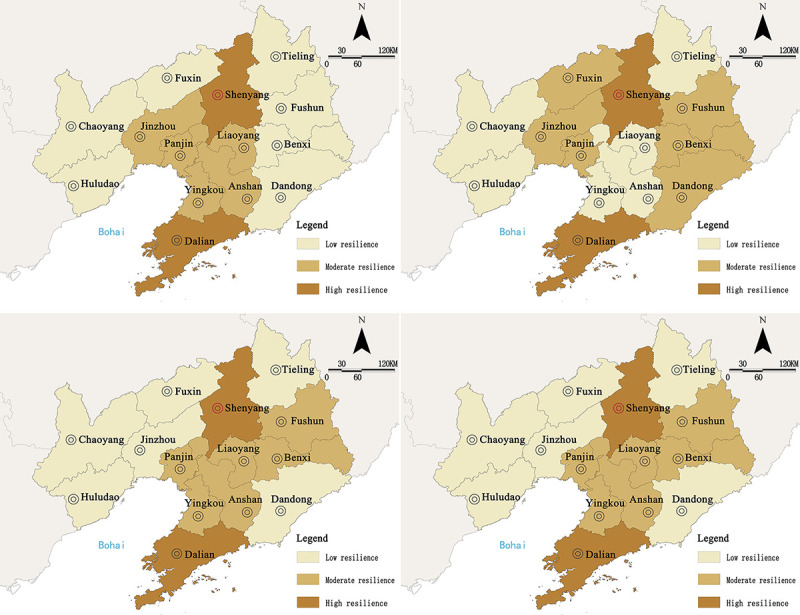
Spatial distribution of resilience of urban subsystems in Liaoning Province from 2009 to 2019.a. Economic resilience. b. Social resilience. c. Engineering resilience. d. Ecological resilience. (Source of base map: the open source map data service provided by the National Platform for Common GeoSpatial Information Services (https://www.tianditu.gov.cn/)).